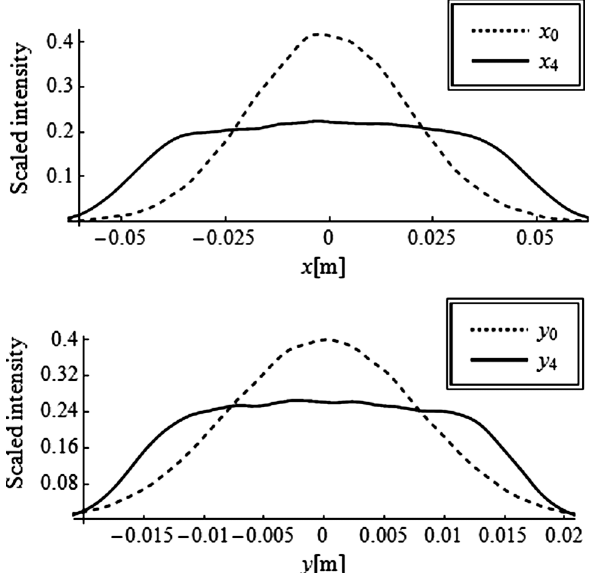
FIG. 6. Real-space scaled intensity distribution at the target in the horizontal direction (the upper plot) and the vertical direction (cid:2) . The dashed curve stands for (the bottom plot) when ’ ¼ 13 : 466 180 the initial Gaussian distribution, the solid curve stands for the uniformed beam distribution, the slope of the solid curve is the impact of the x 0 0 and y 0 0 terms in the expression of x 4 and y 4 .